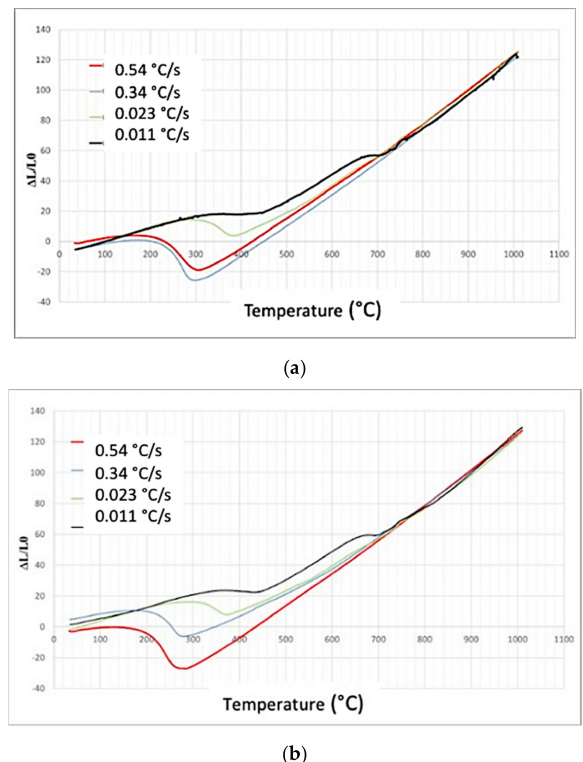
Figure 3. Dilatometric curves of the considered steel: ( a ) austenitization at 980 ◦ C; ( b ) austenitization at 1200 ◦